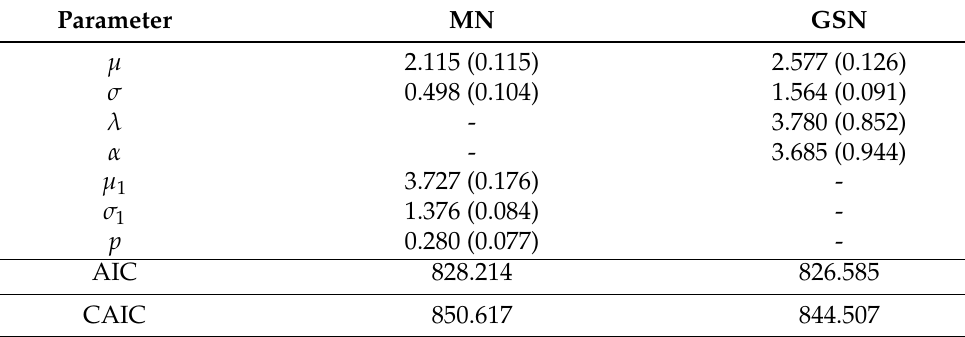
Table 6. Parameter estimates (SE) for MN and GSN